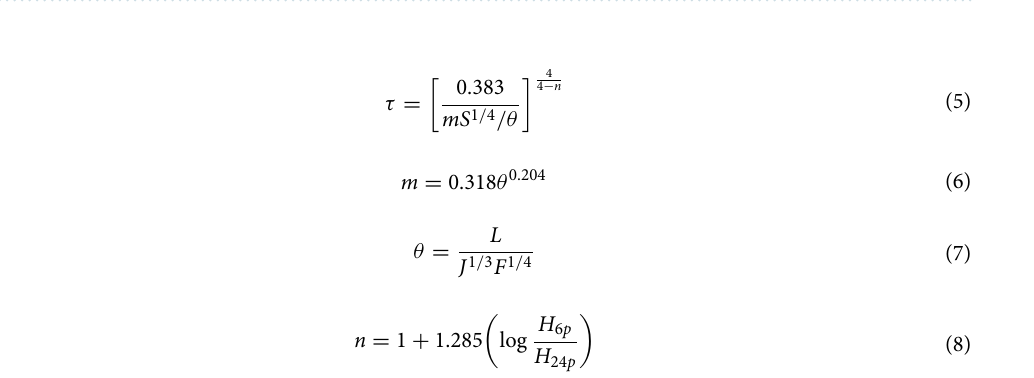
Figure 8. Distribution of hourly and accumulated rainfall on August 18–21,